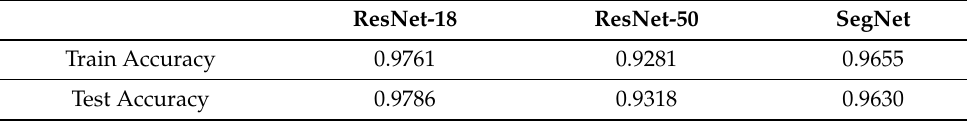
Table 10. Train and test set accuracies of the proposed